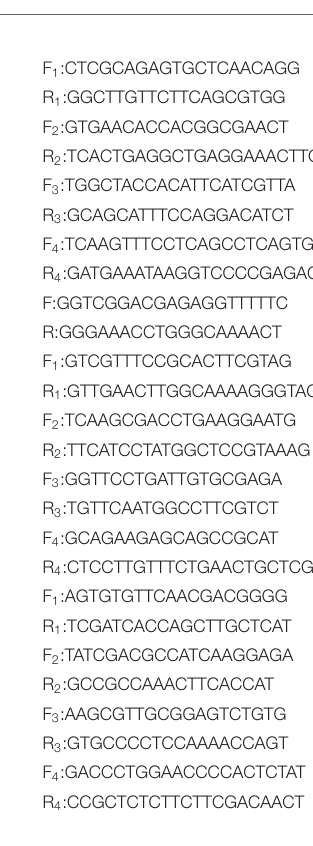
TABLE 1 | Primer sequences used for cDNA cloning, real-time quantitative PCR, and dsRNA synthesis. Tick